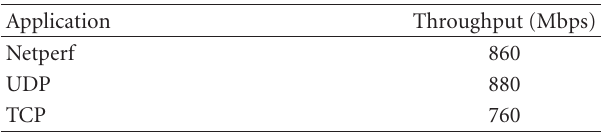
Table 5: Throughput test